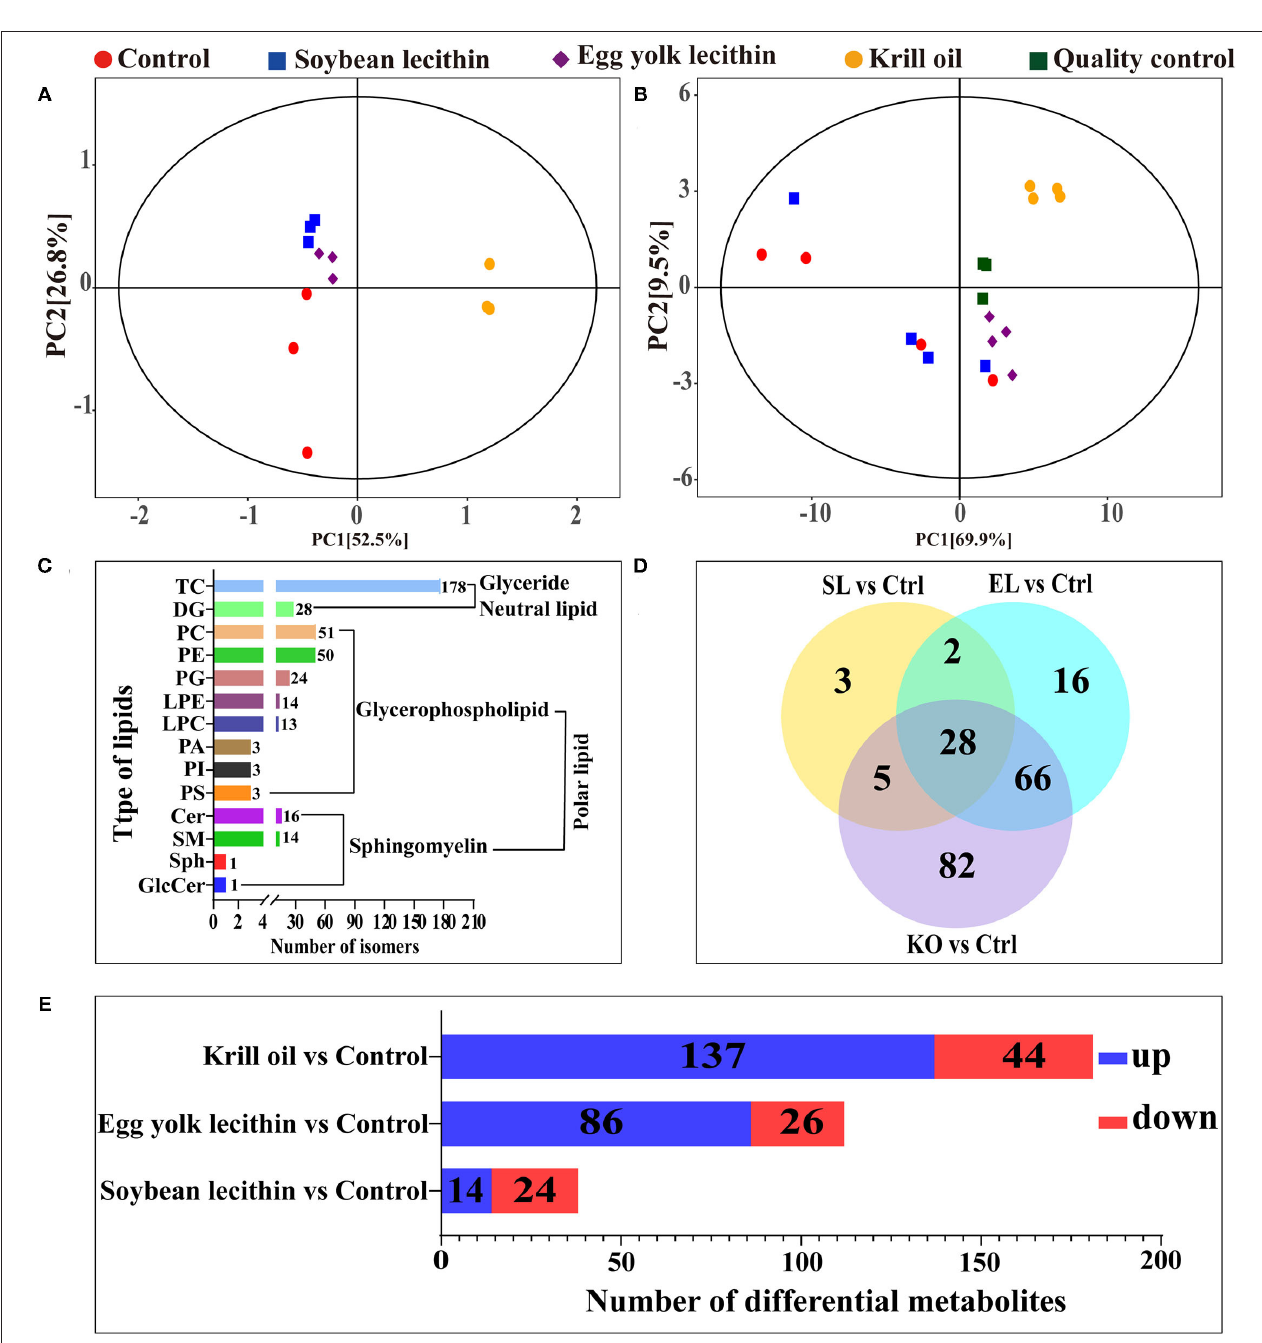
FIGURE 6 | Ovarian lipidomic analysis of different phospholipid source diets. (A) Total dispersion point diagram of the principal component analysis (PCA) model for the experimental diet ( n = 3). (B) Score scatter plot for the TOTAL PCA model with quality control of ovarian tissue ( n = 4). (C) Amount of (sub)class within the entire lipidome in ovarian tissue. There are one neutral lipid (glyceride) and two polar lipids (glycerophospholipid and sphingomyelin). (D) Venn plot of differential lipid metabolites at the comparison between each treatment group and the control group. (E) The number of up- and downregulated differential lipid metabolites was identified at the comparison between each treatment group and the control group. Ctrl (control, phospholipid-devoid), soybean lecithin (SL; added 4% SL), egg yolk lecithin (EL; added 4% EL), krill oil (KO; added 4%